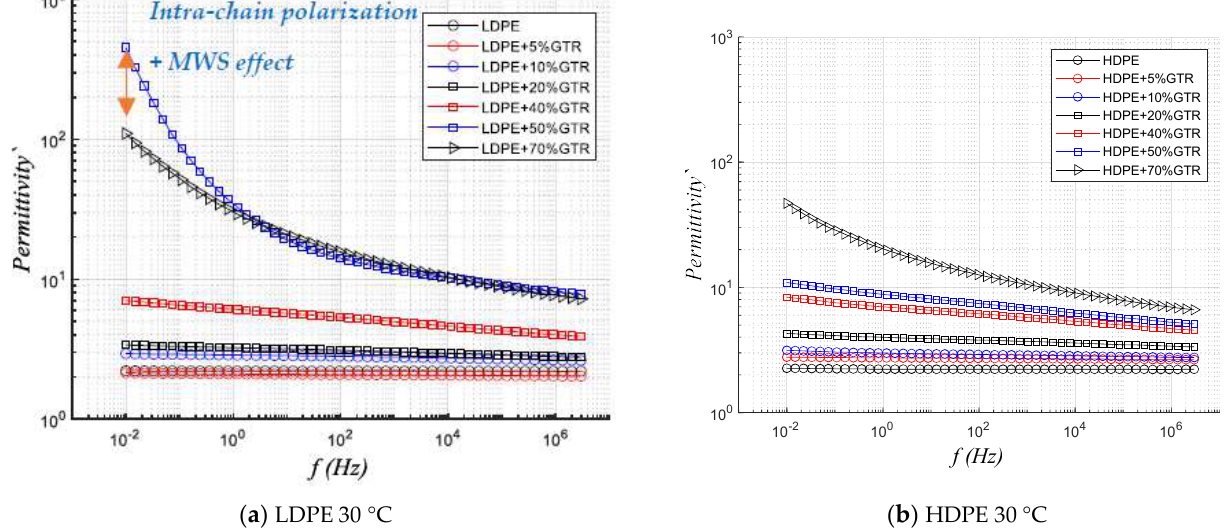
Figure 5. Frequency dependence response of real permittivity, at 30 ◦ C of ( a ) LDPE/GTR compounds and ( b ) HDPE/ GTR